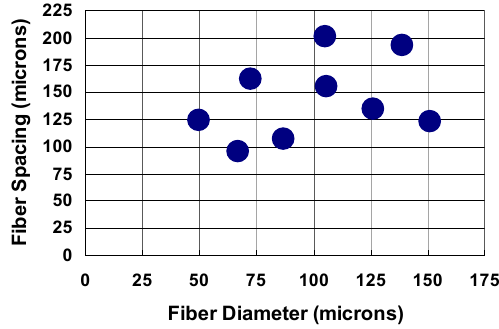
Figure 2. The measured fiber diameter and fiber spacings.